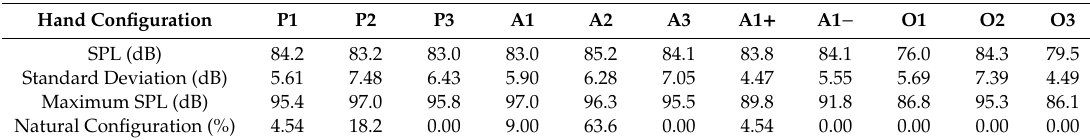
Table 1. Mean Sound Pressure Level (SPL), standard deviation, and maximum SPL for the measured hand configurations.